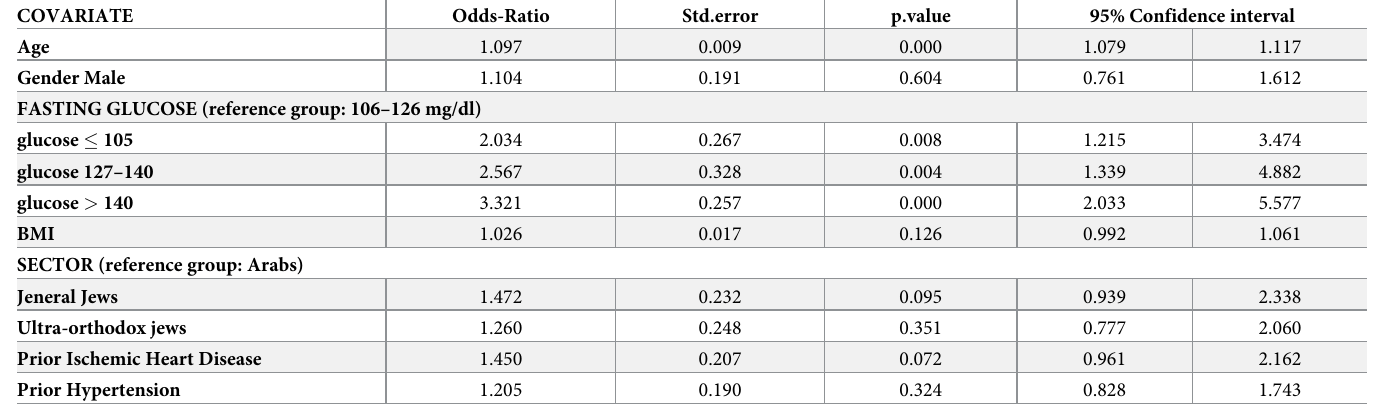
Table 3. Regression results for severe COVID-19 among diabetics (n = 1718).